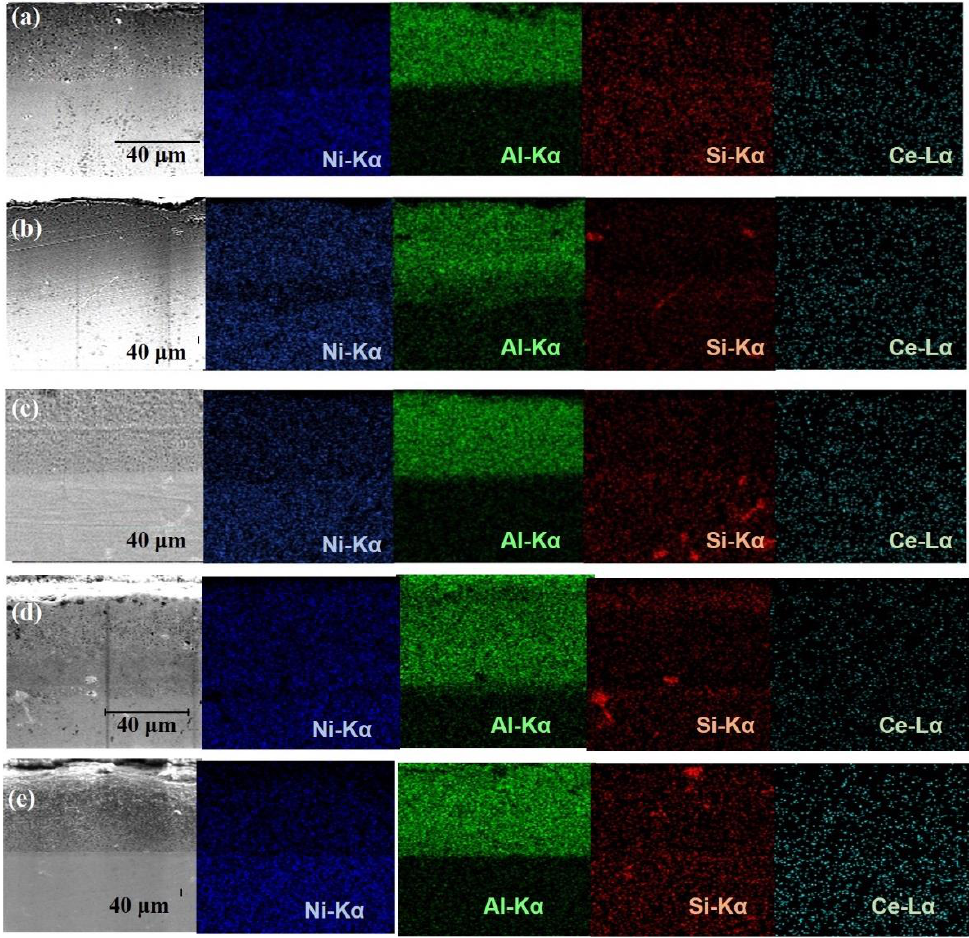
Figure 4. Elemental distribution mapping of Ni, Al, Si, Ce in ( a ) Ce0Si3, ( b ) Ce1Si0, ( c ) Ce1Si6, ( d ) Ce1Si3, and ( e ) Ce2Si3 coatings. ( d ) Ce1Si3, and ( e ) Ce2Si3